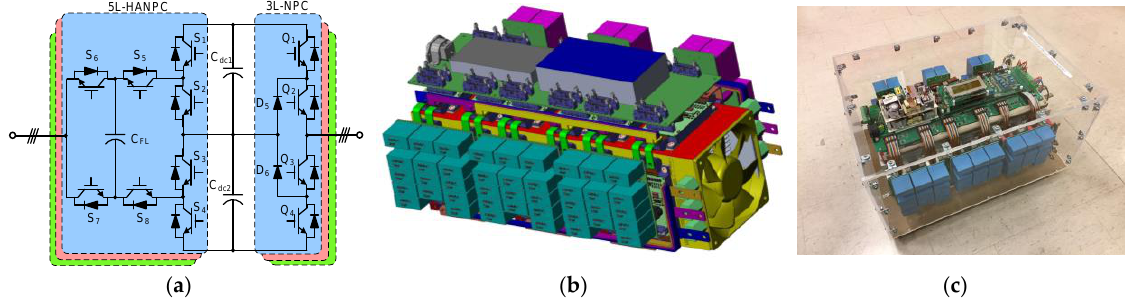
Figure 10. ( a ) Schematic, ( b ) three-dimensional (3D) structure, and ( c ) photograph demonstration of